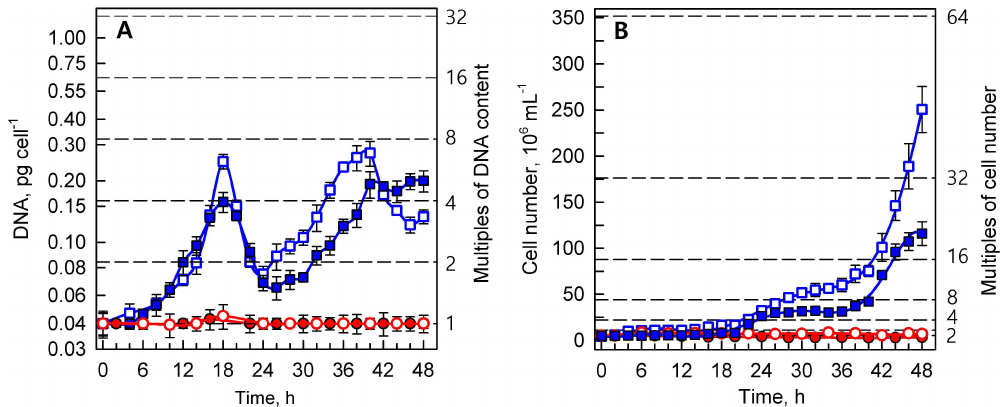
Figure 1. The course of reproductive events in the synchronized cultures of Parachlorella kessleri grown at temperatures of 30 ◦ C and 40 ◦ C (blue and red symbols and lines, respectively), and at incident light intensities of 500 and 110 µ mol photons m − 2 s − 1 (empty and full symbols, respectively). ( A ) DNA (pg cell − 1 ), and ( B ) cell number (10 6 mL − 1 ). Horizontal dashed lines indicate the number of doublings of the initial values at the beginning of the cell cycle (0 h). Multiples of these values are given on the right ordinate. Data are presented as means ± SE. The differences between 30 ◦ C and 40 ◦ C are statistically significant at p < 0.001 (two-way ANOVA) in both A and